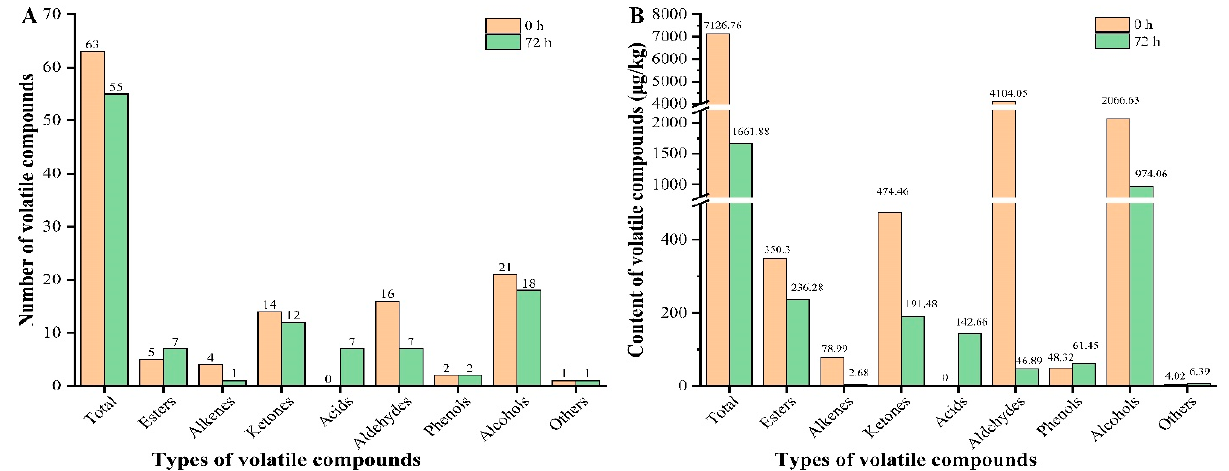
Figure 4. Changes in volatile substances before and after fermentation. ( A ) Number of volatile compounds; ( B ) content of volatile compounds. Table 2. Key flavor substances and their OAV values of SHLE before and after